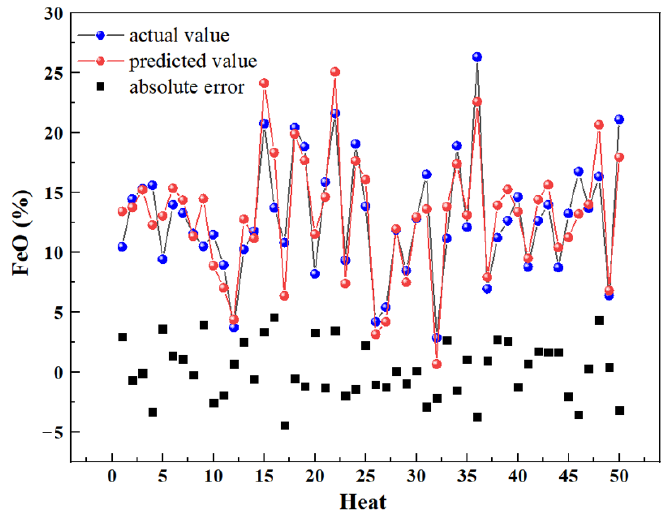
Figure 3. Comparison of actual FeO values and predicted FeO values based on MLR.